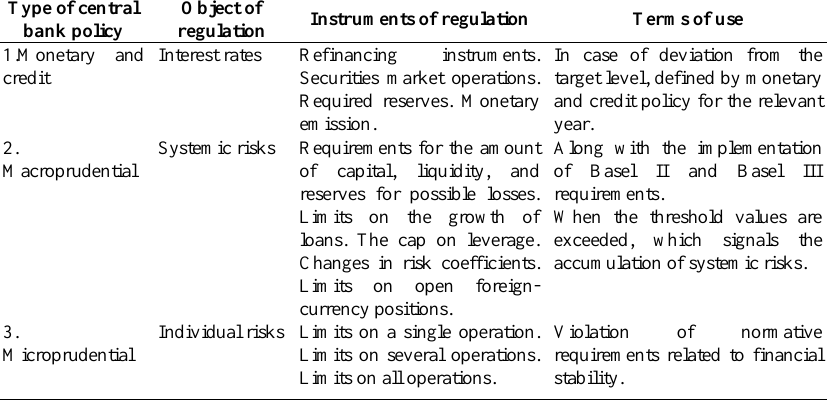
Table 2. Instruments for regulation of financial